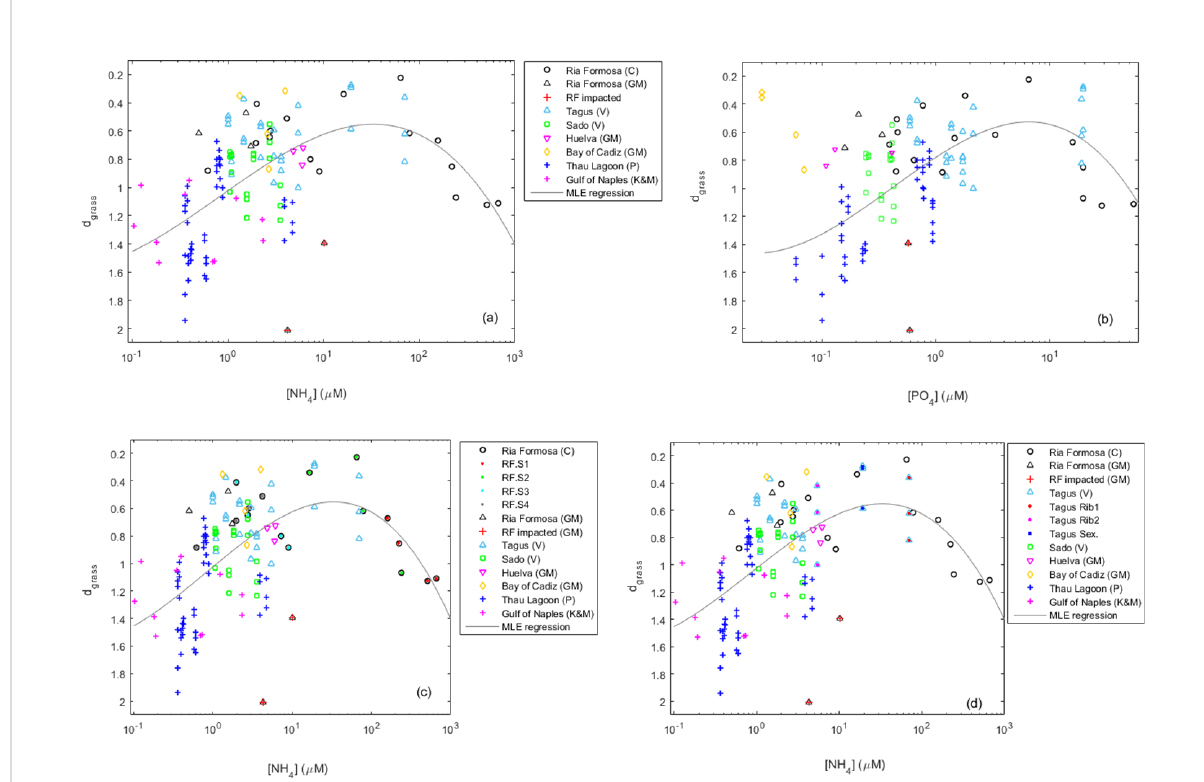
FIGURE 3 Health of Zostera noltei meadows in Portugal, namely, in the Ria Formosa lagoon system and the Tagus and Sado estuaries, and its dependency on ammonium (A, C, D) and phosphate (B) concentrations in the water. Z. noltei meadows in Portugal are compared with other Z. noltei meadows from elsewhere. Original data comes from this study (V), Kraemer and Mazella (1999) (K&M), Plus et al. (2001) (P), Cabac ̧ o et al. (2008) (C), and Garc ı ́ a-Mar ı ́ n et al. (2013) (GM). The Z. noltei health is indicated by its ef fi ciency of space occupation, in its turn indicated by its distance (d grass ) to the seagrass IBL. Panel (C) highlights the Ria Formosa (RF) case, with stations S1, S2, S3, and S4 sorted in increased distance from Montenegro ’ s WWTP. Panel (D) highlights the Tagus case. The Seixalinho station (Sex) is immediately outside Seixalinho WWTP, whereas Ribeiralves stations are immediately outside (Rib1) and 300 m away (Rib2) from Ribeiralves fi sh factory ef fl uent. Trends fi t by maximum likelihood estimation